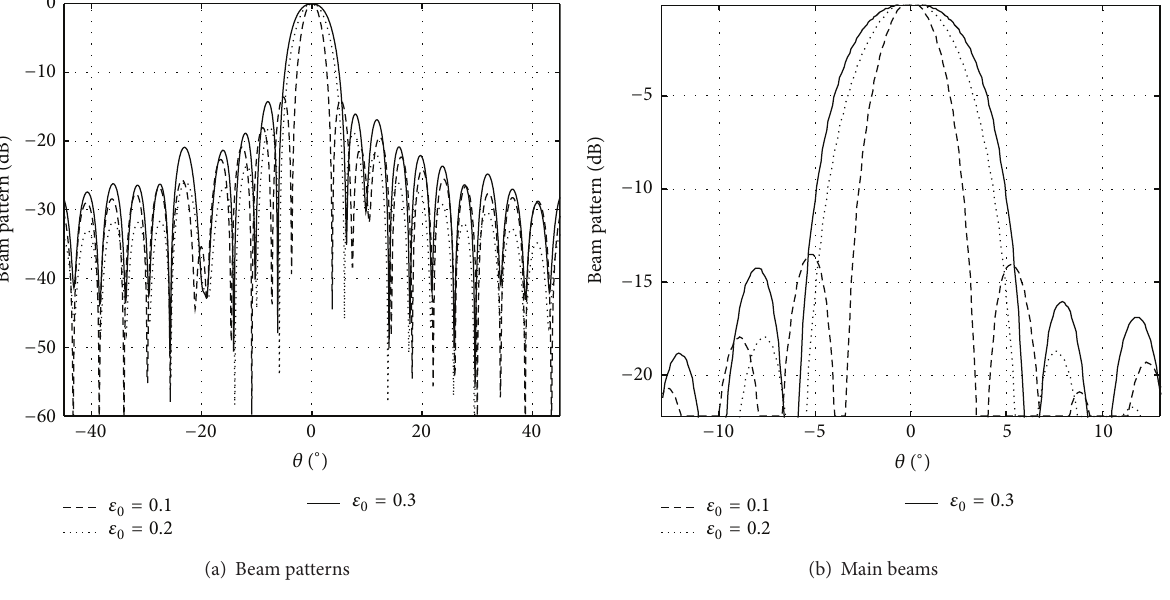
Figure 2: Various beamformers’ beam patterns with 2 × 𝑁 snapshots.